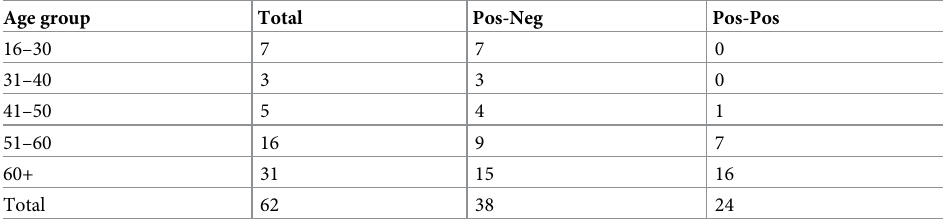
Table 4. Comparison of age of donors losing S protein positivity versus donors maintaining